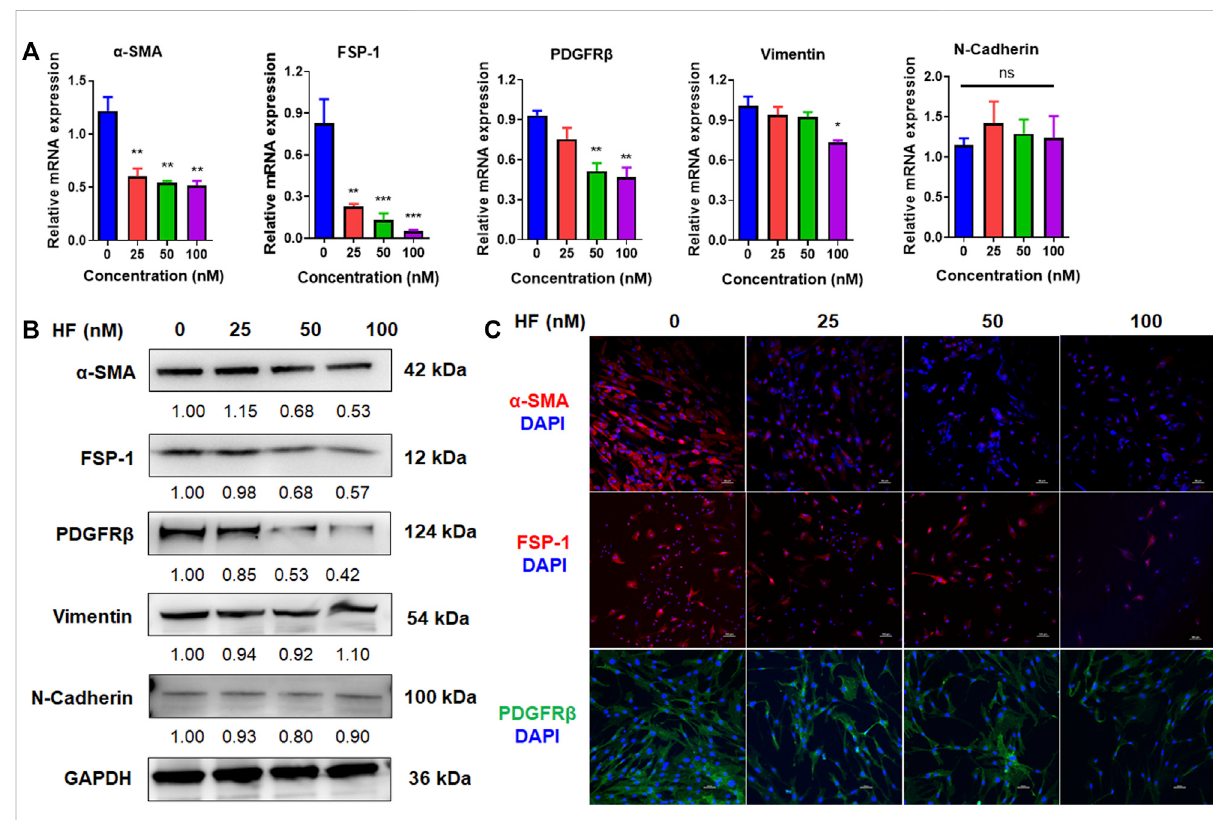
FIGURE 3 Halofuginoneinhibitedthe expressions ofCAF phenotypic markers.CAFs were treatedwith orwithoutHF(25, 50,100 nM) for 48 h.The mRNA andproteinlevelsofCAFphenotypicmarkers α -SMA,FSP-1,PDGFR β , N-cadherin and vimentinweredetected byqRT-PCR (A) andWesternblotting (B) , respectively. (C) The Protein levels of α -SMA, FSP-1, PDGFR β were con fi rmed by immuno fl uorescence assays. *: p < 0.05, **: p <